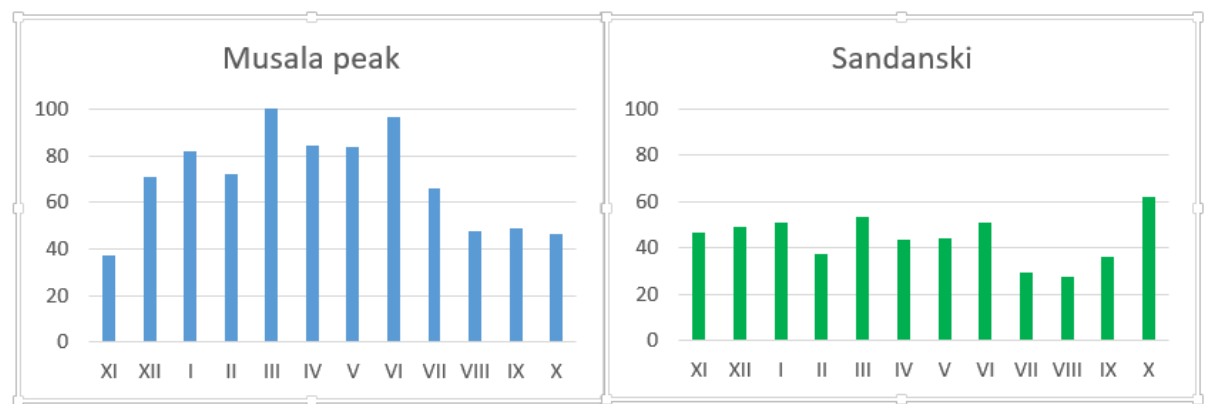
Figure 7. Monthly precipitation (mm) at Musala peak and Sandanski for 2006–2021 (data from [18]).